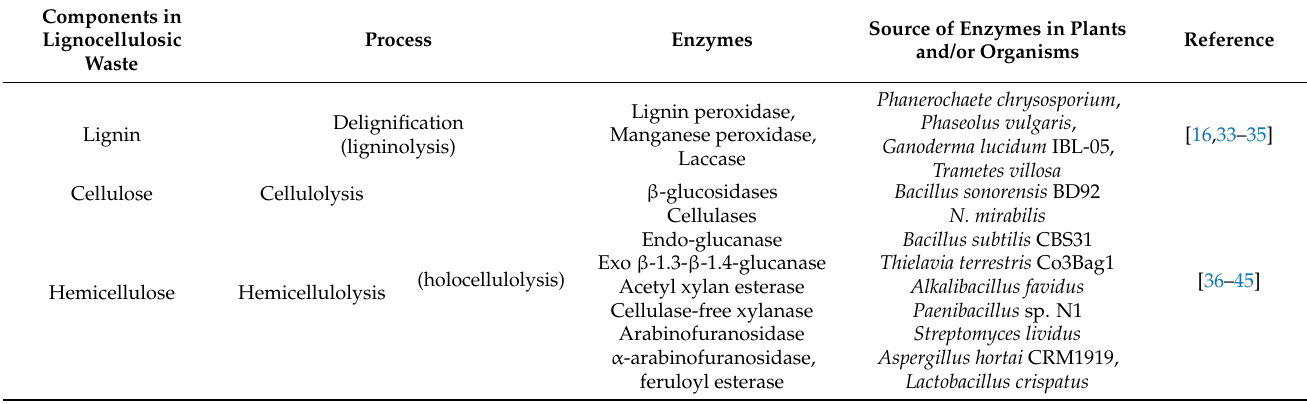
Table 1. Components in lignocellulosic waste, processes and a few examples of enzymes and their source associated with the waste component lysis.